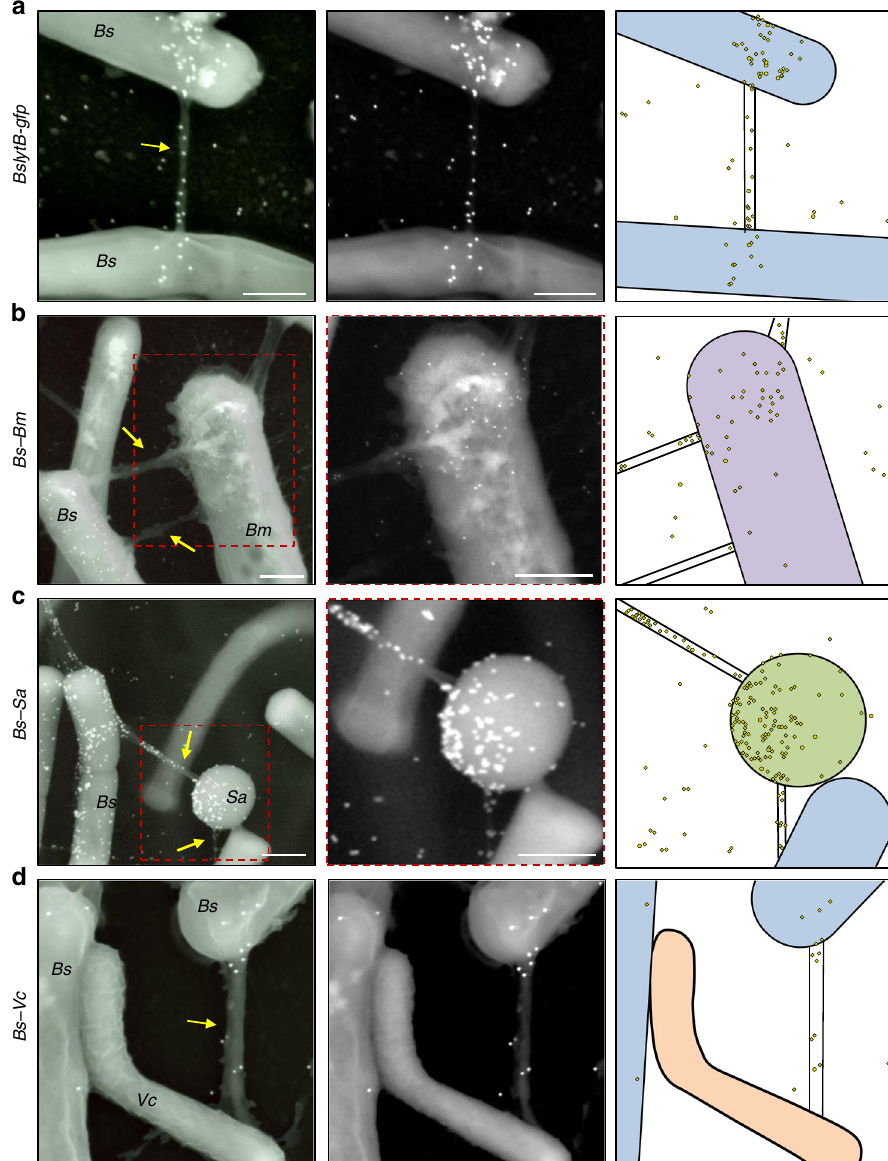
Fig. 3 LytB molecules travel along intercellular nanotubes to reach the recipient cell surface. a Bs cells expressing LytB-GFP (AB144: lytB-gfp , Δ ymdB, amyE ::P hyper-spank -ymdB , Δ hag ) were spotted onto EM grids and subjected to immuno-gold XHR-SEM analysis, using primary antibodies against GFP and secondary gold-conjugated antibodies. Samples were not coated before observation. Shown is an overlay of XHR-SEM images acquired using TLD-SE (through lens detector-secondary electron) for nanotube visualization and vCD (low-kV high-contrast detector) for gold particle (white dots) detection (left panel), and the corresponding vCD image (middle panel). Schematic depicts the interpretive cell layout and highlights the region with gold signal captured by XHR-SEM (right panel). b Bs cells expressing LytB-GFP (AB170: lytB-gfp, Δ ymdB, amyE ::P hyper-spank -ymdB , Δ hag , Δ wapA ) were mixed with Bm (OS2, lacking GFP), spotted onto EM grids and subjected to immuno-gold XHR-SEM as described in a . Shown is an overlay of XHR-SEM images acquired using TLD-SE for nanotube visualization and vCD for gold particle (white dots) detection (left panel), and a corresponding vCD image of the boxed region (middle panel). Schematic depicts the interpretive cell layout and highlights the region with gold signal captured by XHR-SEM (right panel). c Bs cells expressing GFP tagged LytB (AB144: lytB-gfp , Δ ymdB, amyE ::P hyper-spank -ymdB , Δ hag ) were mixed with Sa (MRSA, lacking GFP), spotted onto EM grids and subjected to immuno-gold XHR-SEM as described in a . Shown is an overlay of XHR-SEM images acquired using TLD-SE for nanotube visualization and vCD for gold particle (white dots) detection (left panel), and a corresponding vCD image of the boxed region (middle panel). Schematic depicts the interpretive cell layout and highlights the region with gold signal captured by XHR-SEM (right panel). d Bs cells expressing GFP tagged LytB (AB144: lytB-gfp , Δ ymdB, amyE ::P hyper-spank -ymdB , Δ hag ) were mixed with Vc (N16961, lacking GFP), spotted onto EM grids and subjected to immuno-gold XHR-SEM analysis as described in a . Shown is an overlay of XHR-SEM images acquired using TLD-SE for nanotube visualization and vCD for gold particle (white dots) detection (left panel), and the corresponding vCD image (middle panel). Schematic depicts the interpretive cell layout and highlights the region with gold signal captured by XHR-SEM (right panel). Each experiment was repeated at least fi ve times independently with similar results. Scale bars represent 500 nm. Arrows indicate intercellular